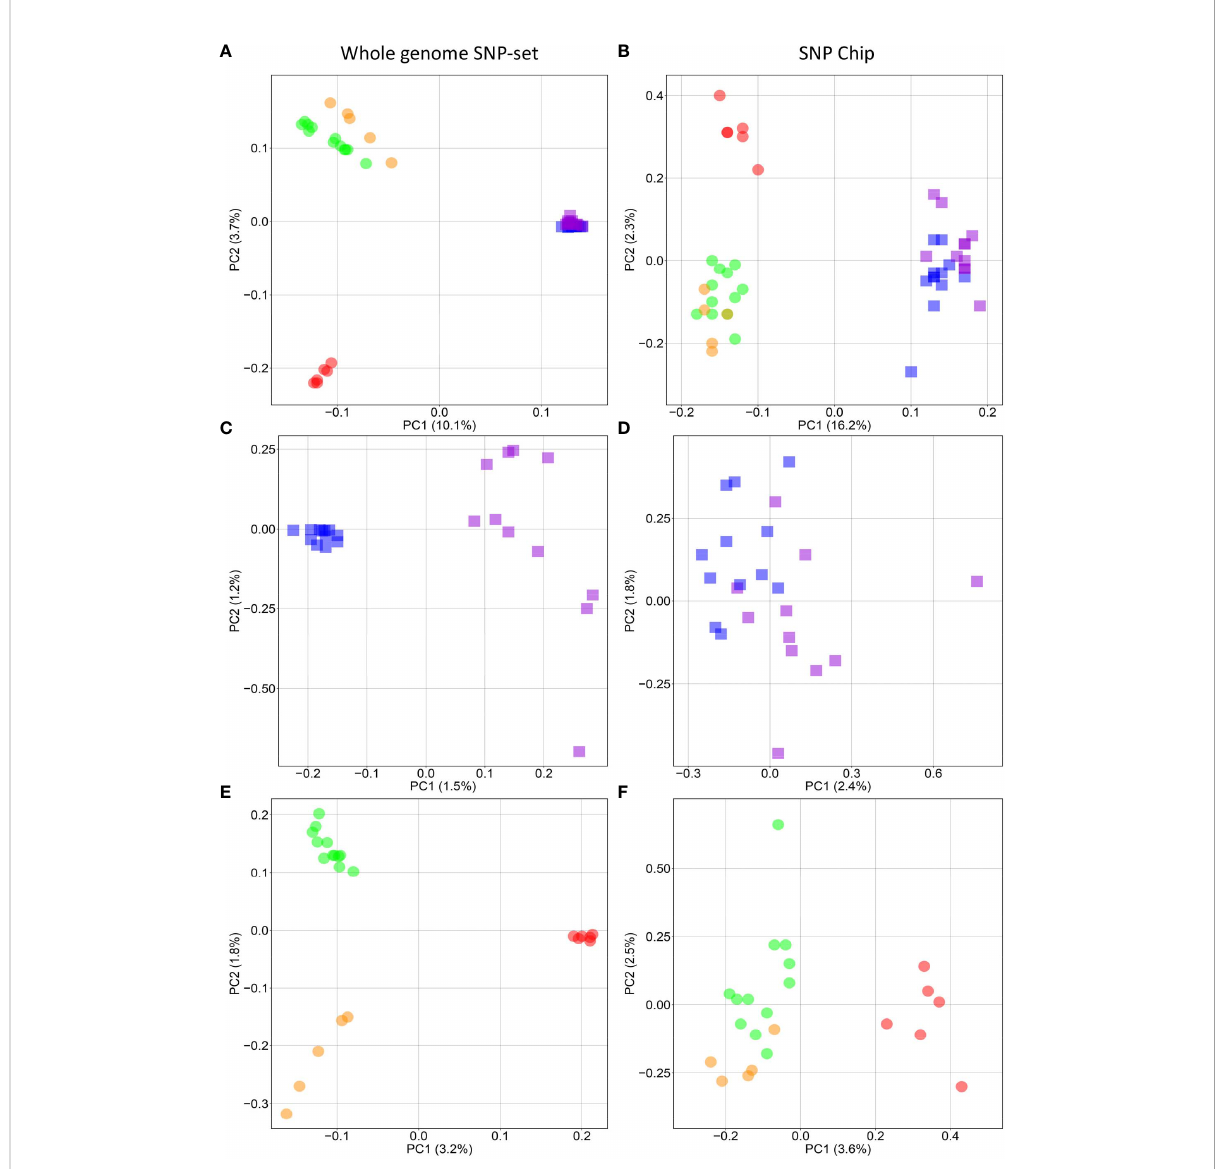
FIGURE 1 Principal Component Analysis (PCA) comparing results of Mnemiopsis leidyi SNP sets from whole genome re-sequencing at 832,323 SNPs (left) and newly developed SNP Chip at 116 SNPs (right) for all native (Miami: red; Woods Hole: blue, USA) and invasive (Sylt: purple, GER; Varna: green, BG; Villefranche-sur-Mer: orange, FR) populations (top panel A, B ), northern populations only (mid panel, C, D ) and southern populations only (bottom panel E, F